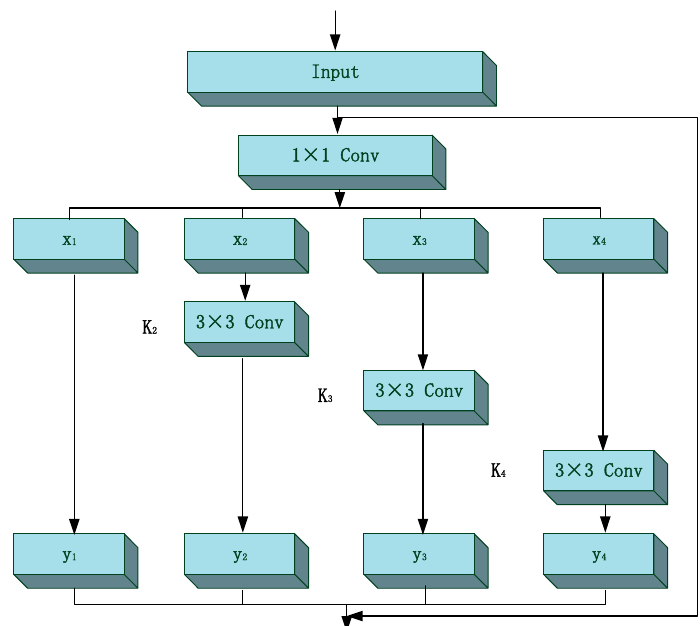
Figure 10. The structure of ‘Res2 unit’.